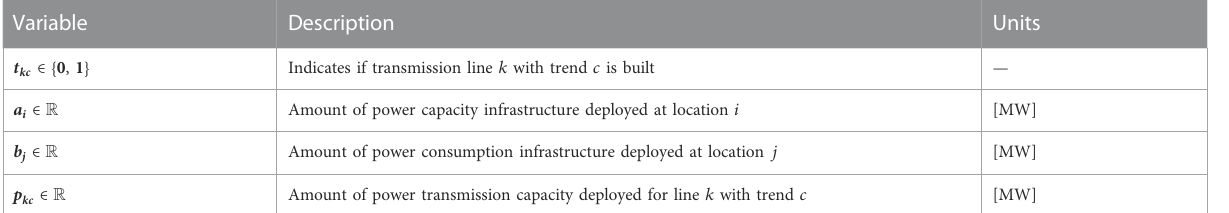
TABLE 3 Decision variables for SimWIND PRO .